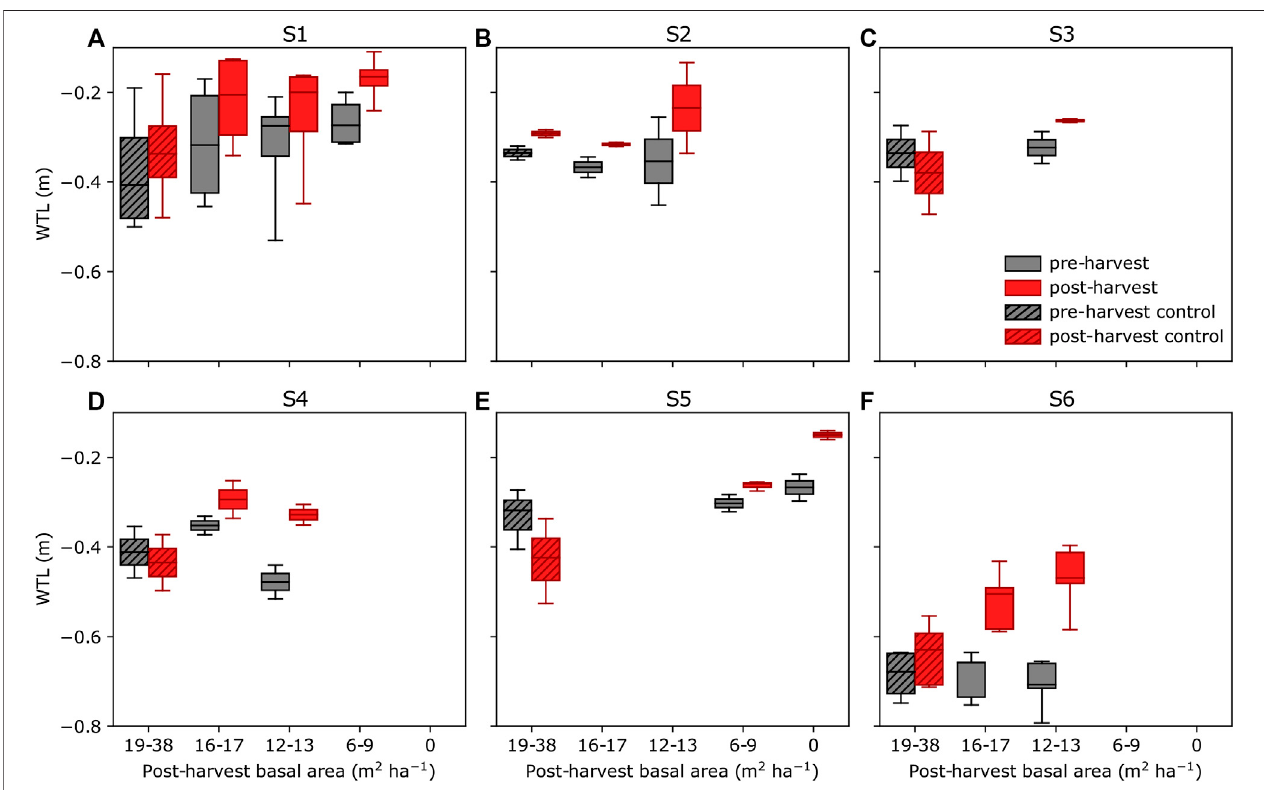
FIGURE 4 | Mean water table level (WTL) before harvest (gray) and after harvest (red) at sites S1 – S6 (A – F) grouped by treatments (see Figure 2 ) during June – October. Data from non-harvested control plots are indicated by hatching. The boxplots indicate the median, the 25 – 75% percentile, and the min – max range.